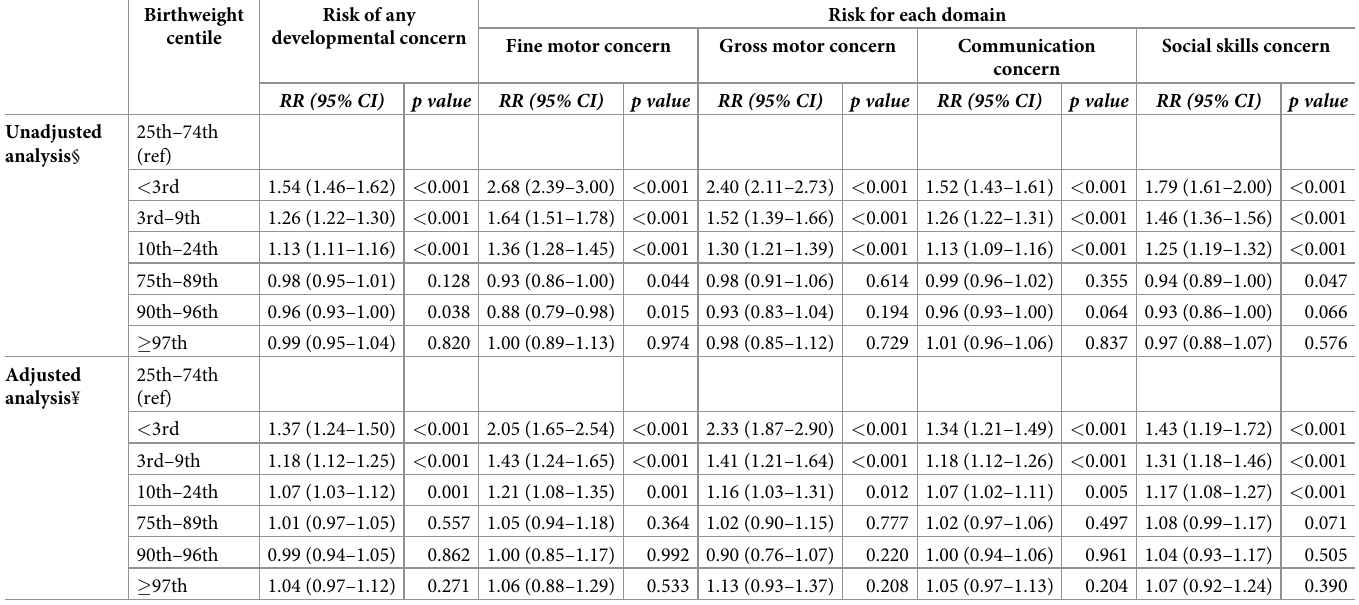
Table 2. Adjusted RR with 95% confidence intervals of developmental concerns at chosen birthweight centiles referent to the birthweight between 25th and 74th centiles (for gestational age 37 +0 to 43 +6 ). Birthweight